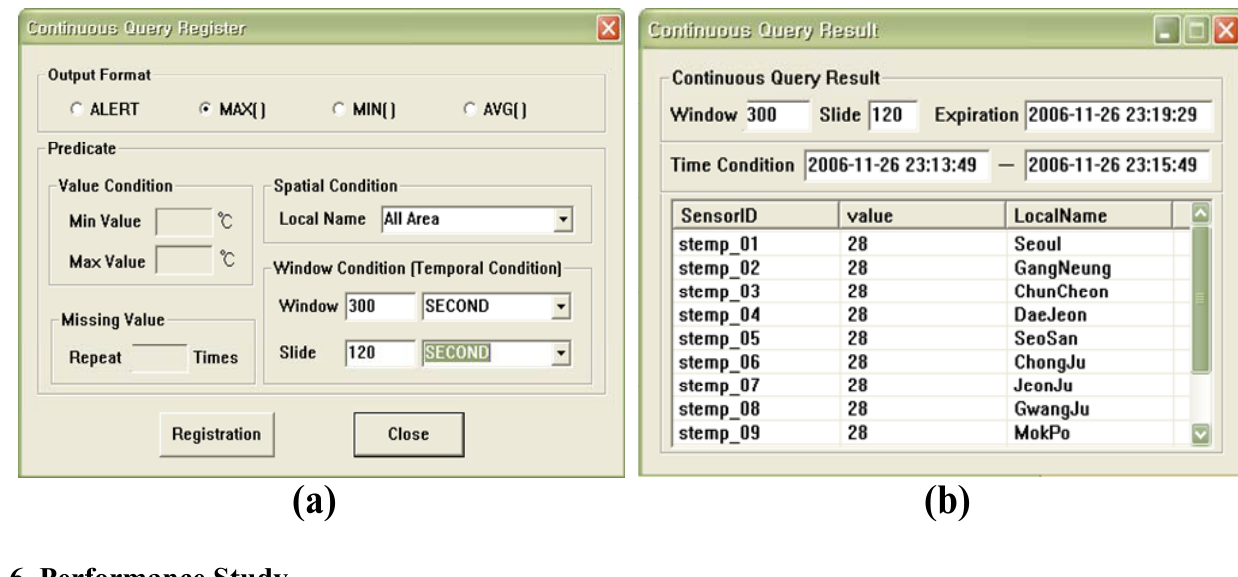
Figure 11. Continuous query registered for spatiotemporal query processing in which ( a ) registers the information for a spatiotemporal query; ( b ) displays the view of the detected event according to the registered